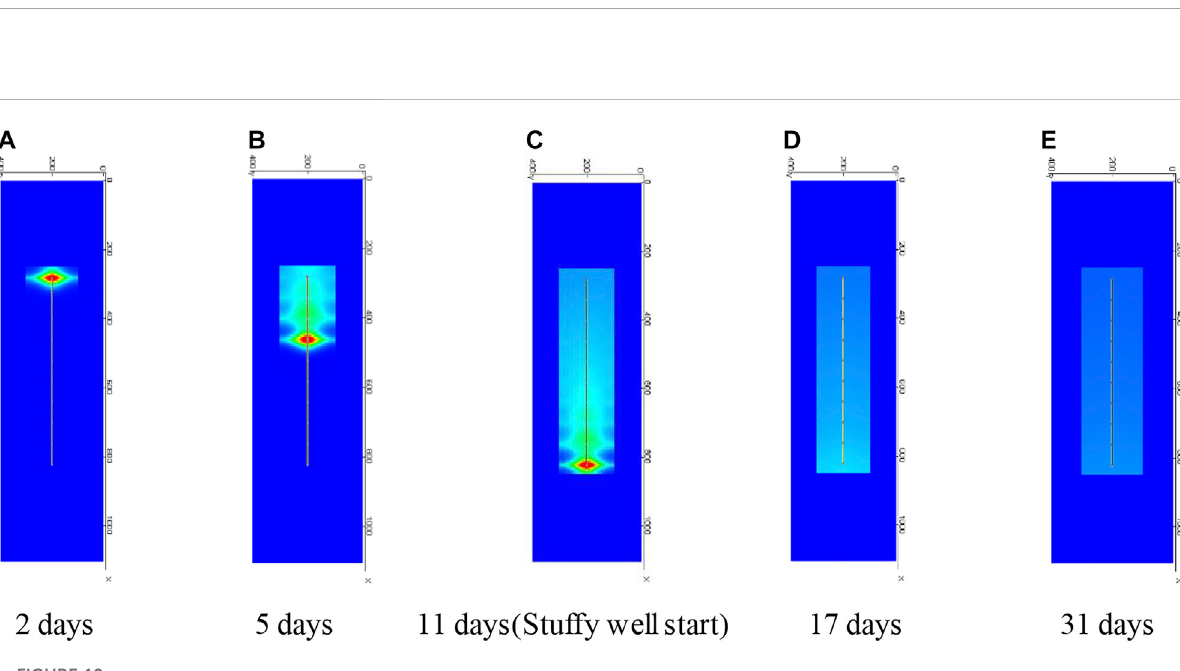
FIGURE 10 Pressure distribution of the lamellation-fracture system during the shut-in period. (A) 2 days, (B) 5 days, (C) 11 days, (Stuffy well start) (D) 17 days, and (E) 31